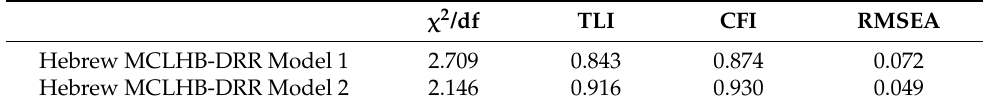
Table 4. Goodness of fit indices for Hebrew MCLHB-DRR model.